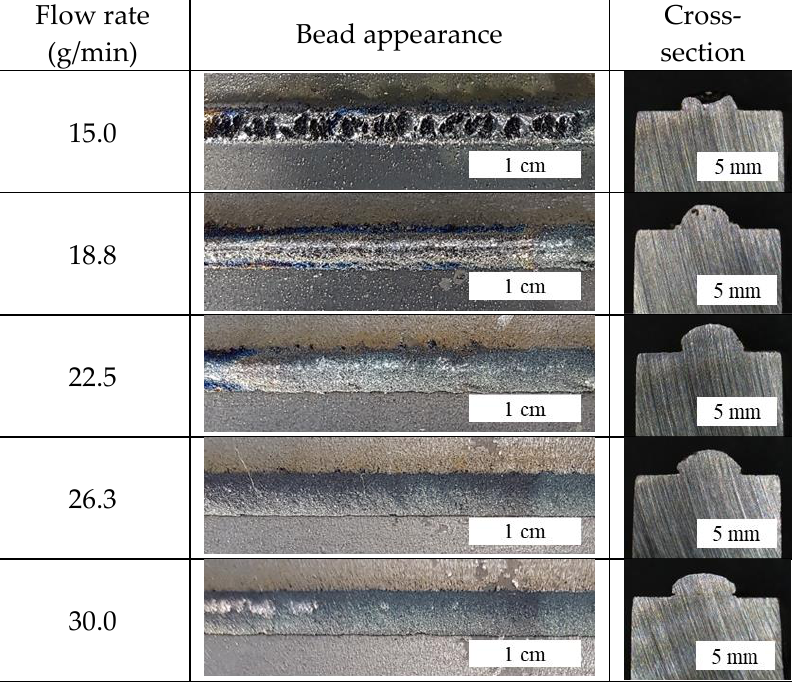
Figure 9. Bead appearance and cross-section of bead with various flow rate from 15.0 to 30.0 g/min.